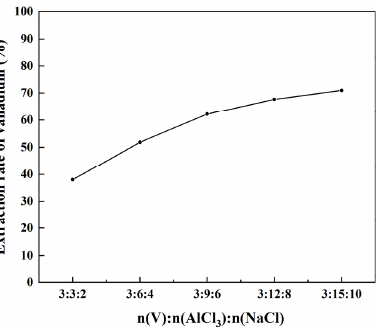
The e ff ects of the AlCl 3 and NaCl dosage (V:AlCl 3 :NaCl = 3:3:2, 3:6:4, 3:9:6, 3:12:8, and 3:15:10 mol/mol) on the vanadium extraction rate and VOCl 3 purity were examined at 170